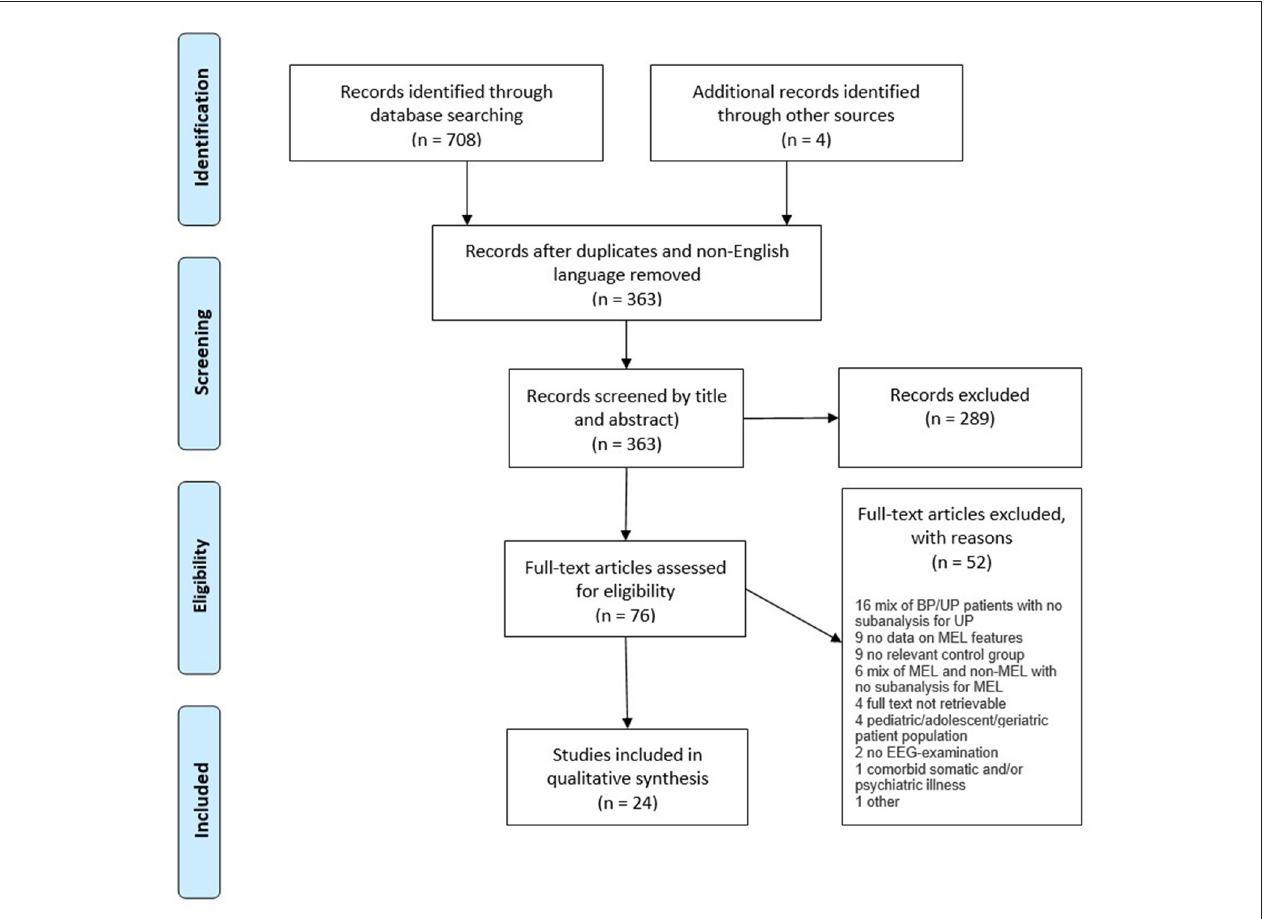
FIGURE 1 | Study flow